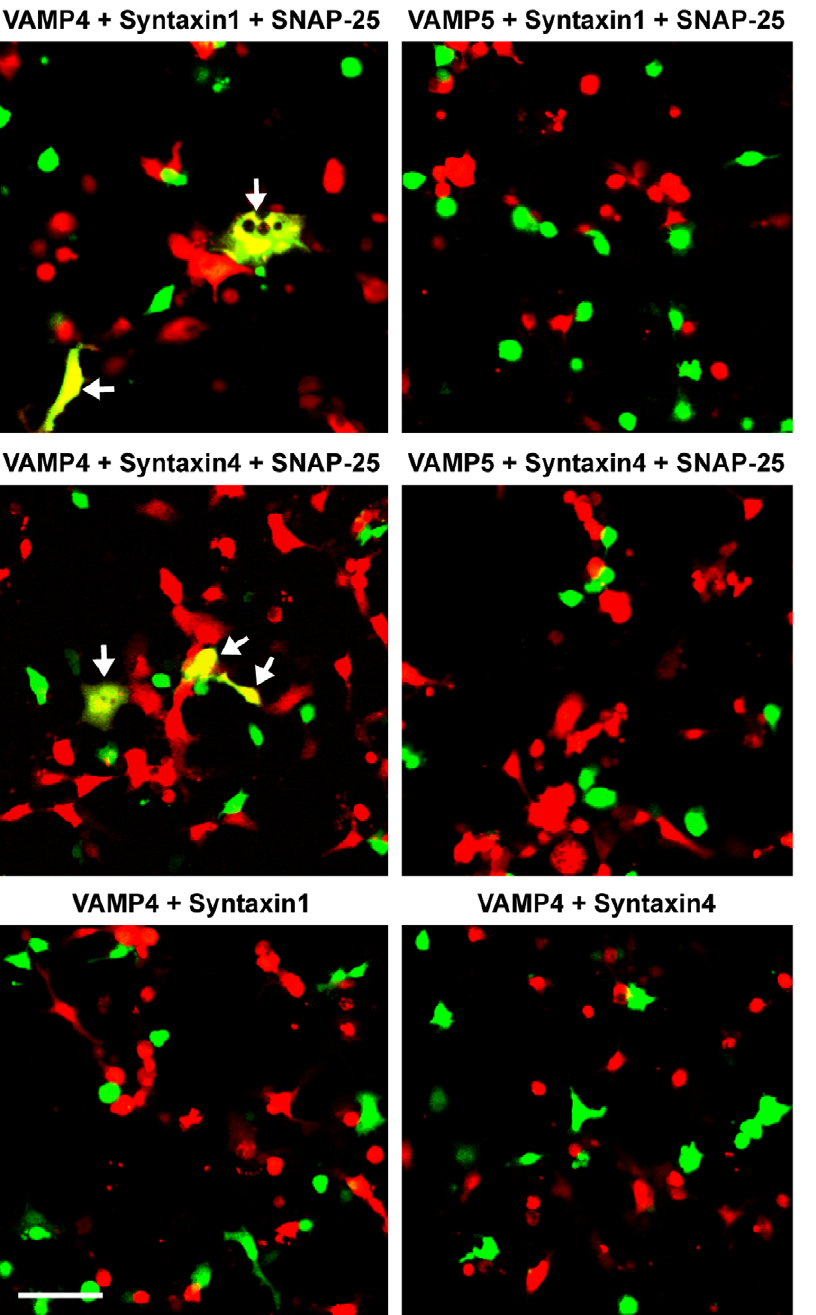
Figure 6. VAMP5 does not mediate membrane fusion with plasma membrane t-SNAREs. v-cells expressing VAMPs 4 or 5 were labeled by the green fluorescent protein EGFP. t-cells expressing syntaxin1/SNAP-25, syntaxin4/SNAP-25, syntaxin1 alone, or syntaxin4 alone were labeled by the red fluorescent protein DsRed2. The v- and t-cells were combined for 24 h. EGFP and DeRed2 were imaged sequentially on a confocal microscope before merging the images. Representative confocal images of three independent experiments are shown. Arrows indicate fused cells with a yellow cytoplasm. Scale bar, 100 m m. doi:10.1371/journal.pone.0014238.g006 VAMP5 is preferentially expressed in the skeletal muscle and in vesicle trafficking from endosomes to the TGN [24]. Interacting with syntaxin13, syntaxin6 and vti1a, VAMP4 mediates homo- heart and its expression increases during myogenesis [26]. In typic fusion of early endosomes [25]. The current data show that muscle cells, VAMP5 is mainly associated with the plasma VAMP4 drives membrane fusion with plasma membrane t- membrane as well as intracellular vesicles [26,45]. Our data show that VAMP5 is unable to mediate membrane fusion with plasma SNAREs, suggesting that VAMP4 may mediate a third vesicle fusion event - fusion of vesicles with the plasma membrane. membrane t-SNAREs, suggesting that VAMP5 does not mediate